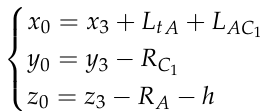
Figure 6. The measurement process of linkage parameters. ( a ) The measurement process of R C L AC . ( b ) The measurement process of x 0 , y 0 , and z 0 1